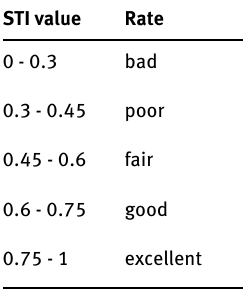
Table 2. Evaluation scale for the values of Speech Transmission Index STI.